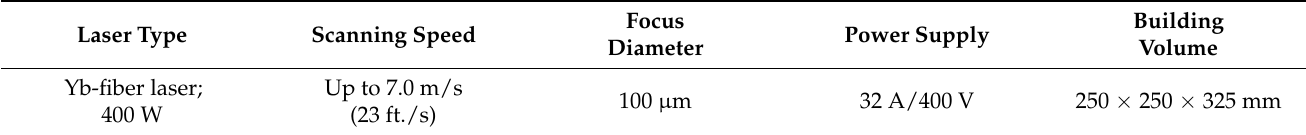
Table 4. Technical data for the EOS M 290